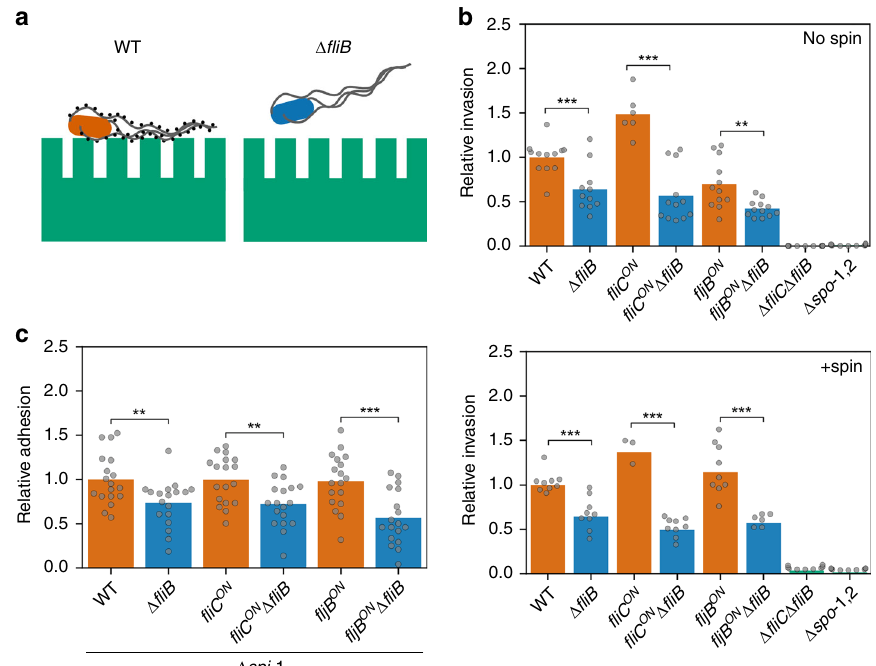
Fig. 4 Flagella methylation facilitates eukaryotic cell adhesion and invasion. a Schematic illustration of Salmonella Typhimurium adhesion to eukaryotic epithelial cells, which is facilitated by methylated fl agella. b Invasion of MODE-K murine epithelial cells by Salmonella Typhimurium expressing methylated or non-methylated fl agella. Reported are relative invasion rates of MODE-K epithelial cells for various fl agellin methylation mutants without (top: no spin) or with forced contact of the bacteria by centrifugation (bottom: + spin). The bar graphs represent the mean of the reported data. Top: n = 12 biologically independent samples for the WT, fl iC ON Δ fl iB , fl jB ON , fl jB ON Δ fl iB , Δ fl iC Δ fl jB , and Δ spi-1,2 , n = 11 biologically independent samples for Δ fl iB and n = 6 biologically independent samples for fl iC ON . Replicates are shown as individual data points and statistical signi fi cances were determined by a two-tailed Student ’ s t test (** = p < 0.01; *** = p < 0.001. WT vs. Δ fl iB : p = 0.0010, fl iC ON vs. fl iC ON Δ fl iB : p < 0.0001, fl jB ON vs. fl jB ON Δ fl iB : p = 0.0035). Bottom: n = 9 biologically independent samples for the WT, Δ fl iB , fl iC ON Δ fl iB , fl jB ON , Δ fl iC Δ fl jB and Δ spi-1,2 , n = 3 biologically independent samples for fl iC ON and n = 6 biologically independent samples for fl jB ON Δ fl iB . Replicates are shown as individual data points and statistical signi fi cances were determined by a two-tailed Student ’ s t test (*** = p < 0.001. WT vs. Δ fl iB : p = 0.0002, fl iC ON vs. fl iC ON Δ fl iB : p < 0.0001, fl jB ON vs. fl jB ON Δ fl iB : p = 0.0004). c Adhesion of Salmonella Typhimurium to MODE-K epithelial cells is reduced in the absence of fl agella methylation. Adhesion was monitored using Salmonella Typhimurium strains deleted for spi-1 in order to prevent invasion of the eukaryotic host cells. The bar graphs represent the mean of the reported relative invasion rate data normalized to the inoculum. n = 18 biologically independent samples. Replicates are shown as individual data points and statistical signi fi cances were determined by a two-tailed Student ’ s t test (** = p < 0.01; *** = p < 0.001. WT vs. Δ fl iB : p = 0.0069, fl iC ON vs. fl iC ON Δ fl iB : p = 0.0033, fl jB ON vs. fl jB ON Δ fl iB : p = 0.0003). Source data are provided as a Source Data fi